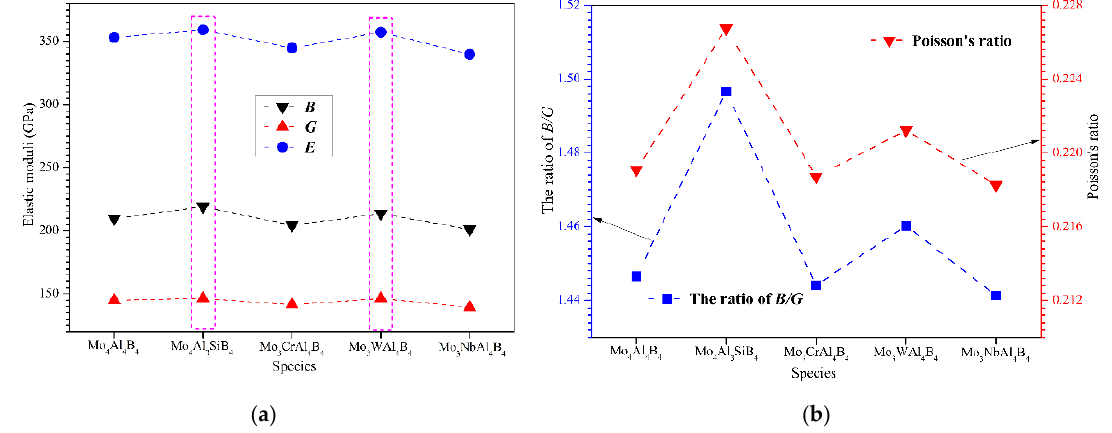
Figure 2. Mechanical properties of MoAlB crystals: ( a ) elastic moduli; ( b ) B / G and Poisson’s ratios.